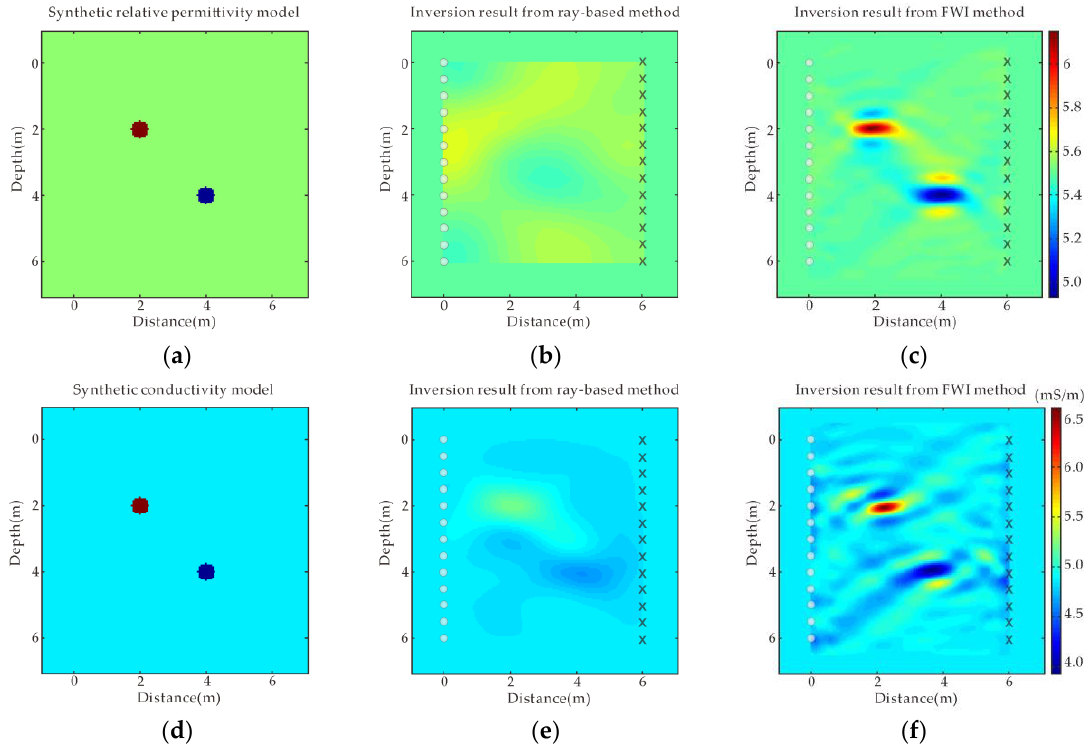
Figure 1. A simple synthetic model with two pipeline bodies buried in homogeneous medium. The model parameters of ( a ) relative permittivity and ( d ) conductivity; ray-based results of ( b ) relative permittivity and ( e ) conductivity; full waveform inversion (FWI) results of ( c ) relative permittivity and ( f ) conductivity.